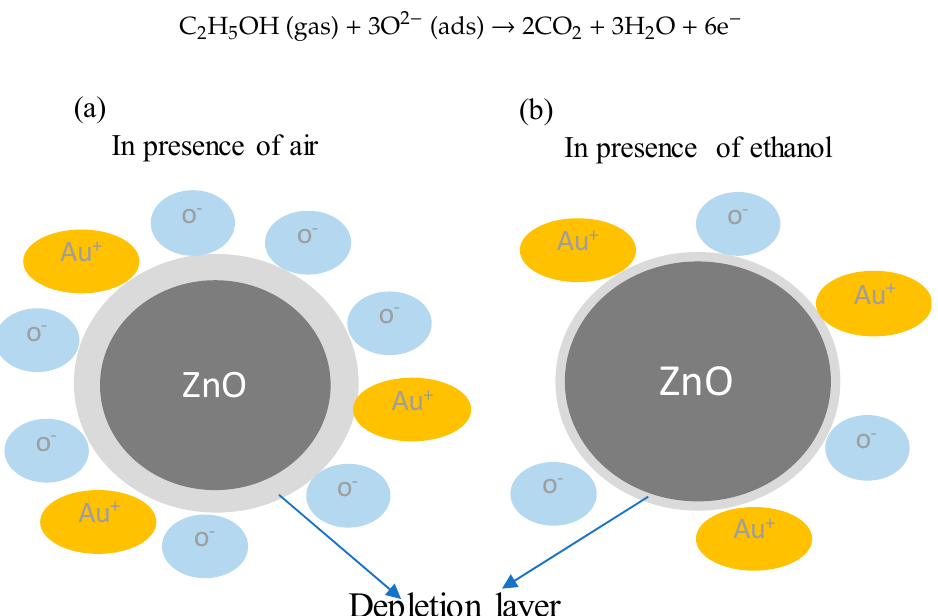
Figure 11. ( a ) AZO sensor in presence of air and ( b ) in presence of ethanol.